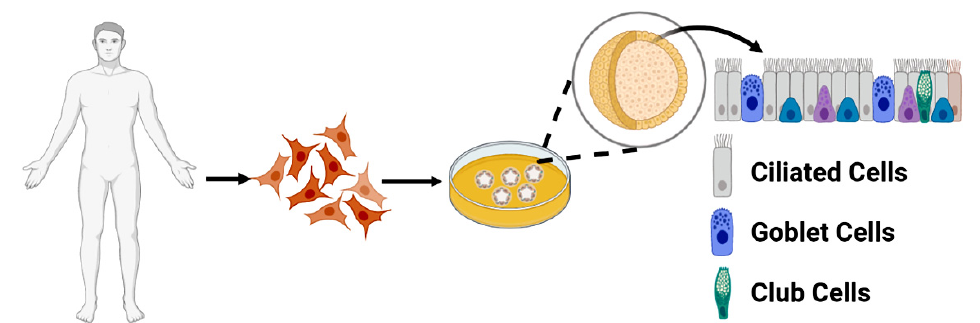
Figure 1. Diagram demonstrating the morphology of an organoid model. Tissue biopsies containing stem cells (in this case patient-derived ASCs) are able to be extracted and then cultured in a Matrigel that allows the organoid to take its three-dimensional form. The organoid will differentiate into the different cell types of its native tissue, in this case intestinal epithelium. Intestinal epithelium consists of multiple cell type tissue containing intestinal stem cells, transit amplifying cells and differentiated cells (ciliated cells, goblet cells, and club cells).